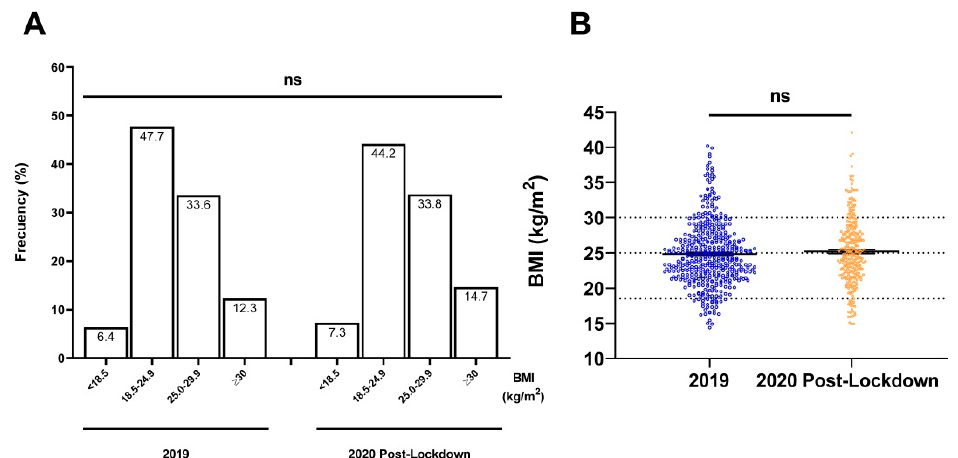
Figure 3. Comparison of body mass index (BMI) ( A ) segregated by weight categories: underweight (< 18.5 kg/m 2 ), normal weight (18.5 ‒ 24.9 kg/m 2 ), overweight (25.0 ‒ 29.9 kg/m 2 ), and obesity ( ≥ 30.0 kg/m 2 ) and ( B ) by study periods: patients with cancer admitted in 2019 versus during the post lockdown in 2020. Differences were assessed by χ 2 ( A ) and two-tailed unpaired Student’s t -test ( B ); ns,